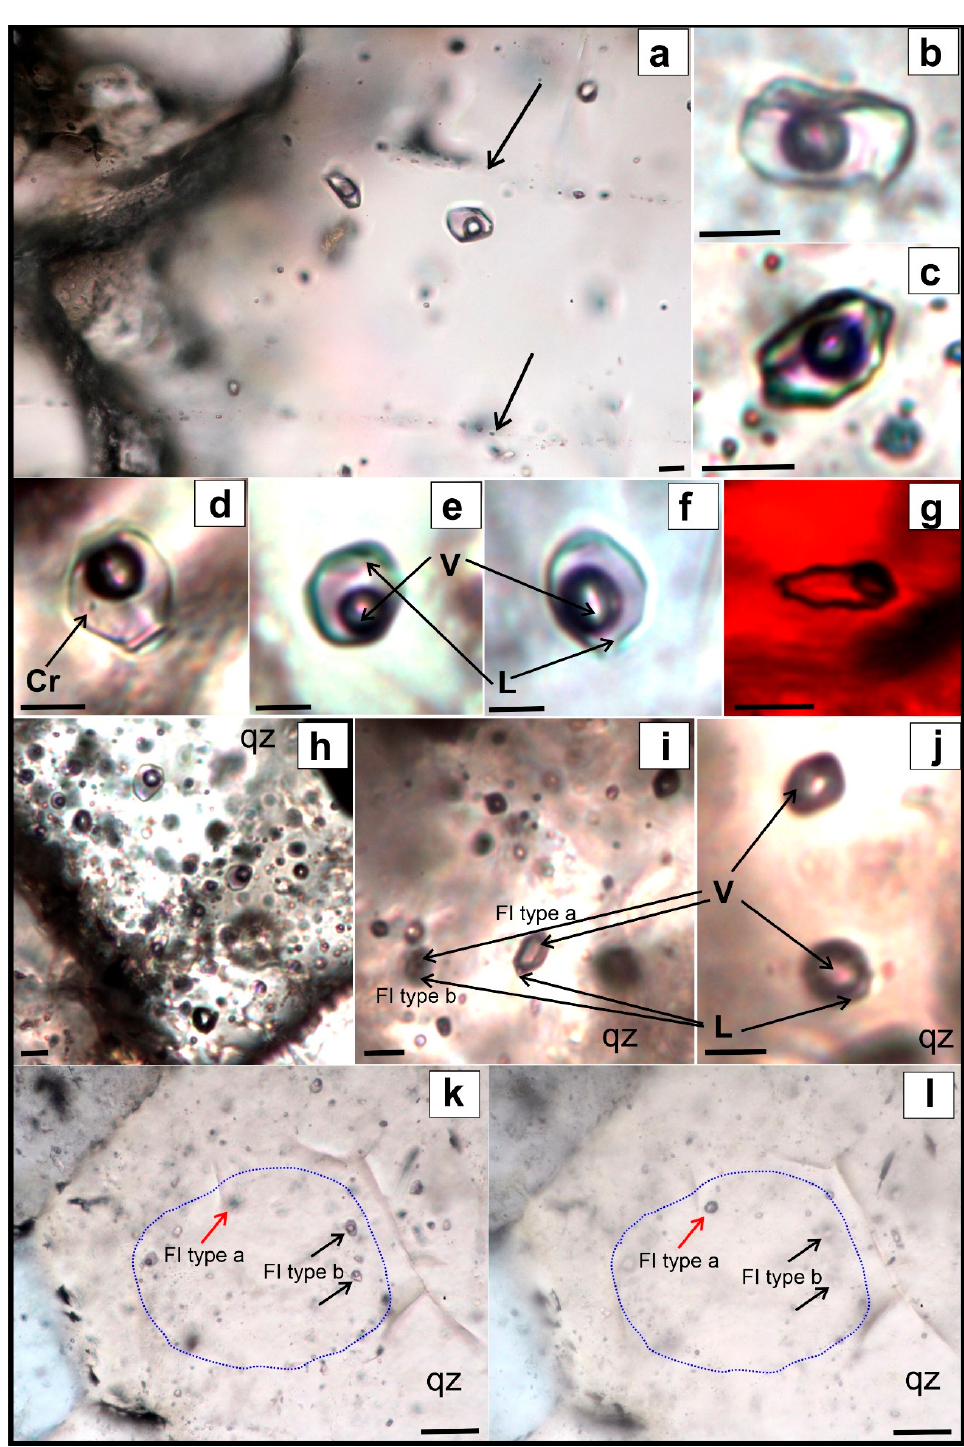
Figure 6. Fluid inclusions from quartz-sulfide-hubnerite veins of the Kholtoson deposit. ( a ) Quartz grain with primary two-phase fluid inclusions, which are located between healed cracks of secondary inclusions (shown by arrows); ( b , c ) primary two-phase fluid inclusions in quartz grains; ( d ) primary inclusion with small dark-colored solid phase (marked as Cr) in fluorite; ( e , f ) primary inclusions in fluorite grains; ( g ) primary two-phase FI in the hubnerite grain; ( h ) group of fluid inclusions in quartz; ( i , j ) groups of liquid- and vapor-dominated inclusions; ( k , l ) quartz grain with cogenetic liquid- (type b, black arrows) and vapor-dominated (type a, red arrow) inclusions at different levels; blue dotted line—crystal growth zone. L—liquid, V—vapor. The scale bar length is 10 µ m; ( k , l ) 50 µ